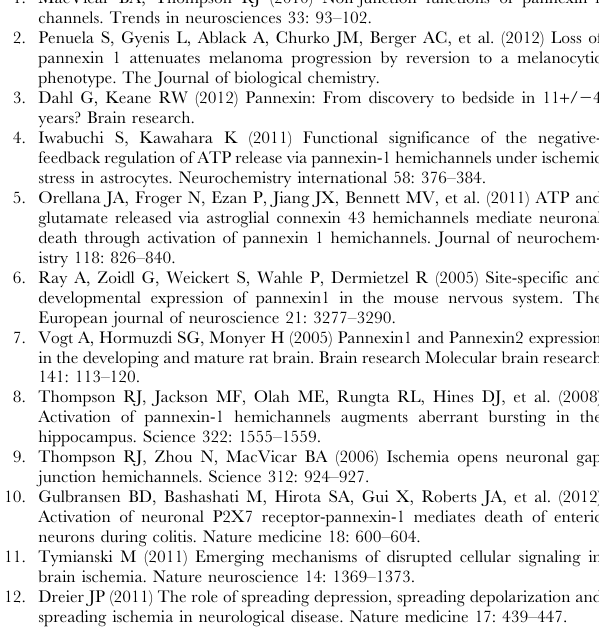
Table S2 Summary of RNA expression profiling data. Summary of data analysis using PCRArrayDataAnalysis_V3.3 software,